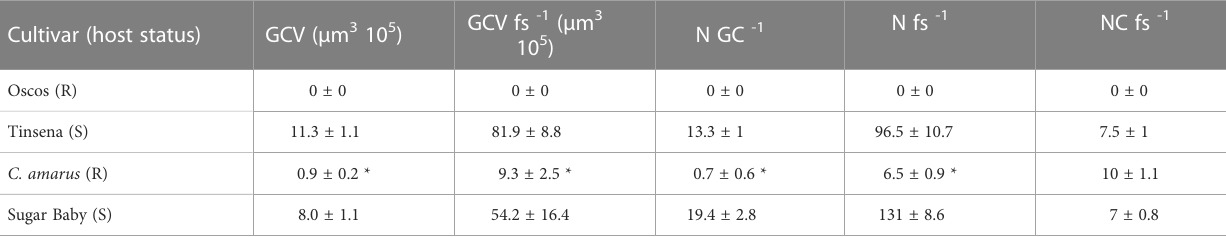
TABLE 4 Giant cell volume (GCV), GC volume per feeding site (GCV fs -1 ), number of nuclei per GC (N GC 1 ), number of nuclei per feeding site (N fs 1 ), and number of cells per feeding site (NC fs -1 ) in the resistant plants (R) pepper rootstock ‘ Oscos ’ and Citrullus amarus and the susceptible plants